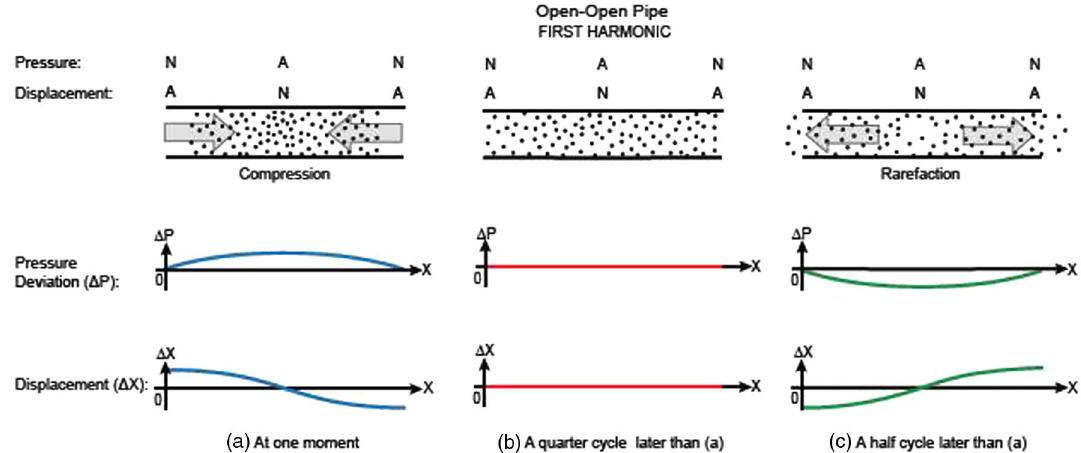
FIG. 2. First harmonic sound standing wave in an open-open